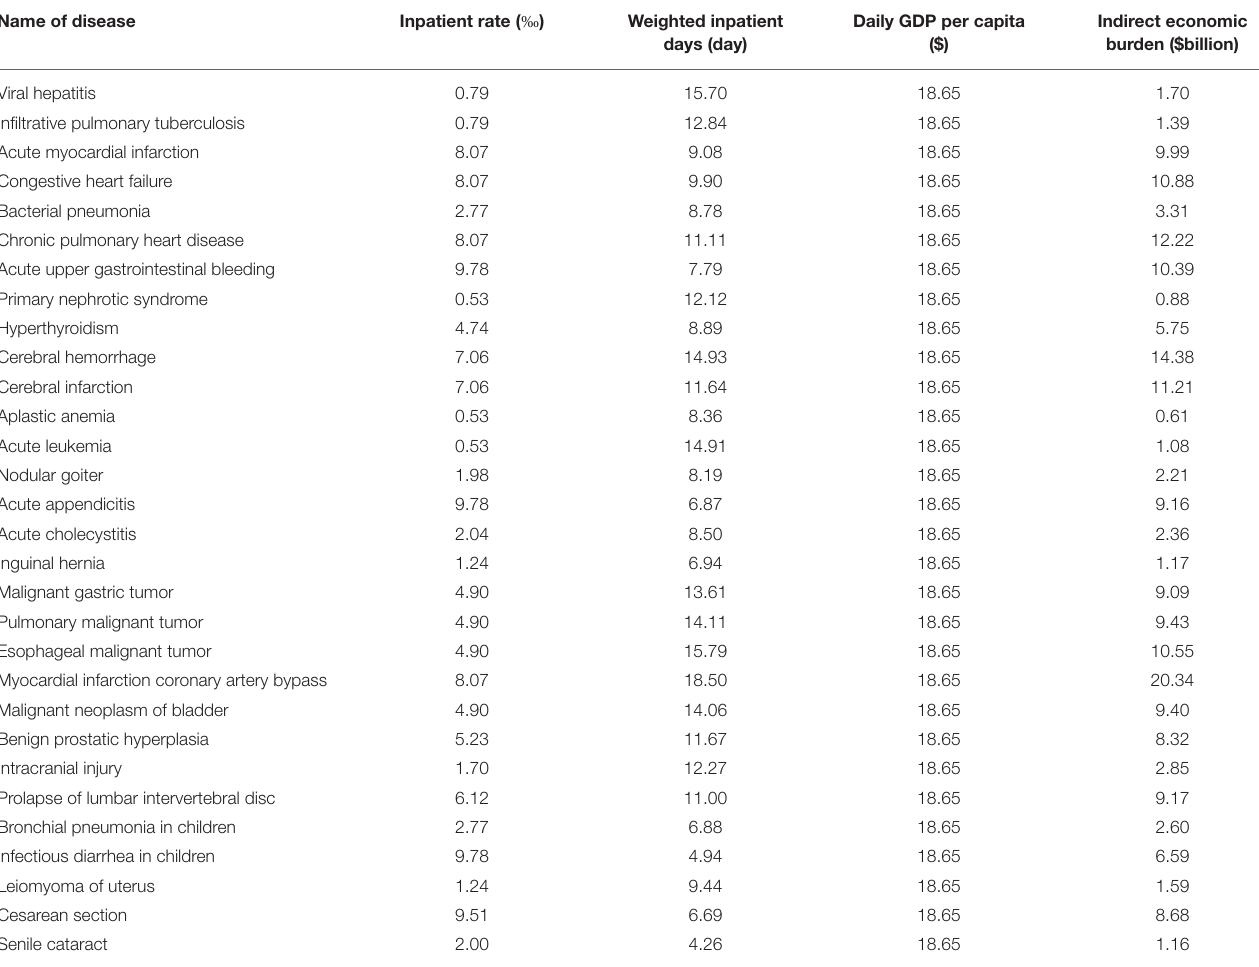
TABLE 3 | Indirect economic burden of 30 types of diseases in urban areas in China in 2013. Name of disease Inpatient rate ( ‰